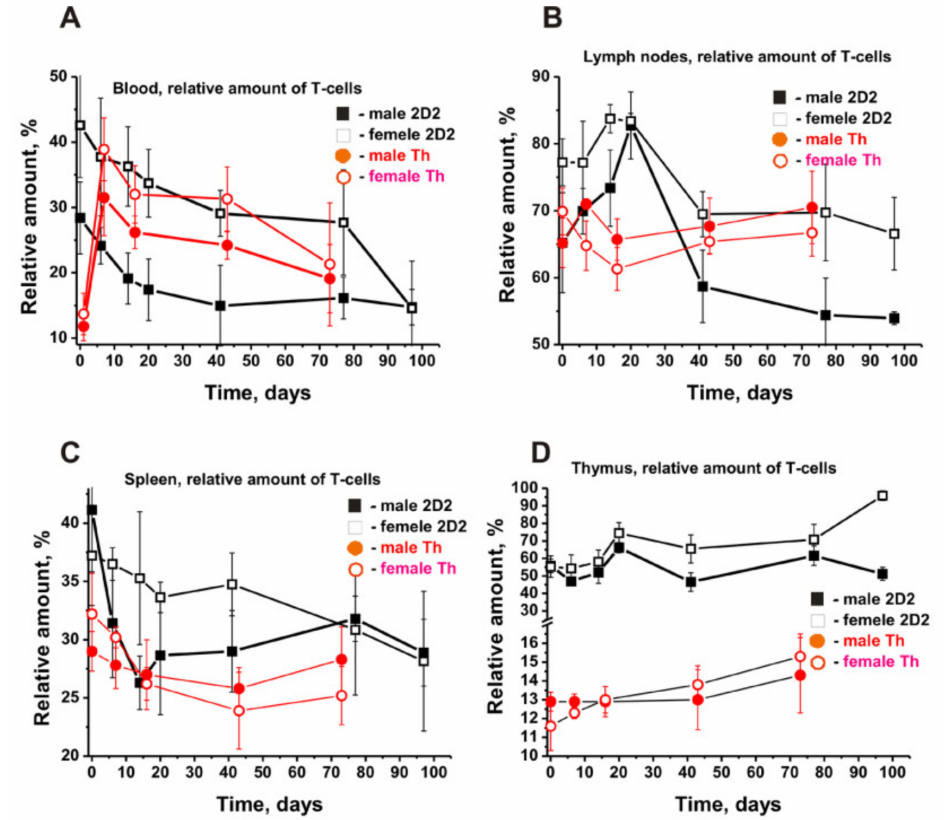
Figure 4. Time-related dependencies in the changes of relative numbers of T cells in various organs of male and female 2D2 (black symbols) and Th (red symbols) mice. All the dependencies for all organs of various males and females are given in ( A – D ) panels. For comparison, the data for Th mice were taken from our previously published articles [38,39]. The duration of the experiment and the time of blood sampling were different for different strains of